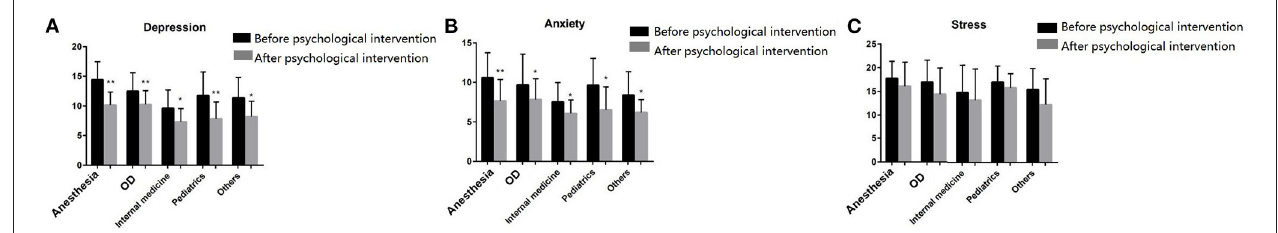
FIGURE 2 | The comparision of DASS before and after psychological intervention among medical students from different majors. The DASS scale contains three emotional states of depression, anxiety, and stress. (A) Depression of DASS; (B) Anxiety of DASS; (C) Stress of DASS. * P < 0.05, ** P < 0.001. OD, Operation Department.